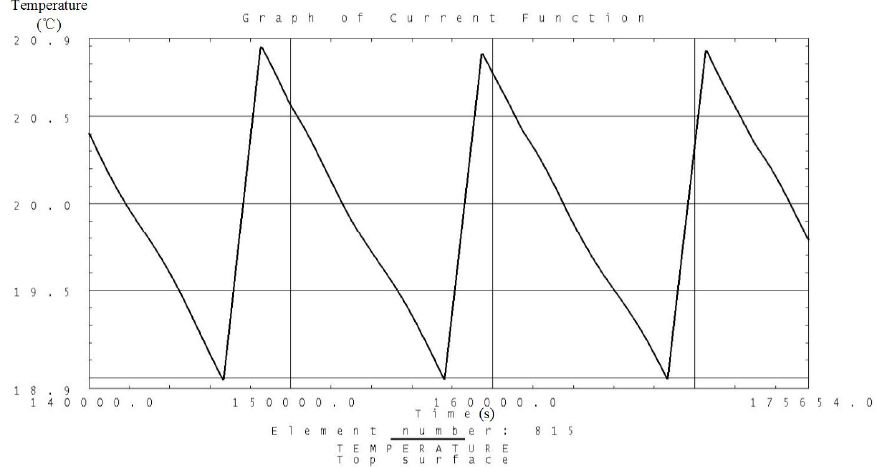
Figure 9. Analysis result of the temperature variation curve of the battery under high temperature conditions.